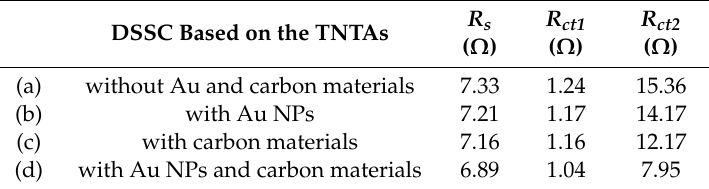
Figure 7. Electrochemical impedance spectra of DSSCs based on freestanding TNTAs ( a ) without Au NPs and carbon materials, ( b ) with Au NPs, ( c ) with carbon materials, and ( d ) with Au NPs and carbon materials. Table 2. Fit parameters of electrochemical impedance spectra of DSSCs based on freestanding TNTAs with / without Ag NPs and / or carbon